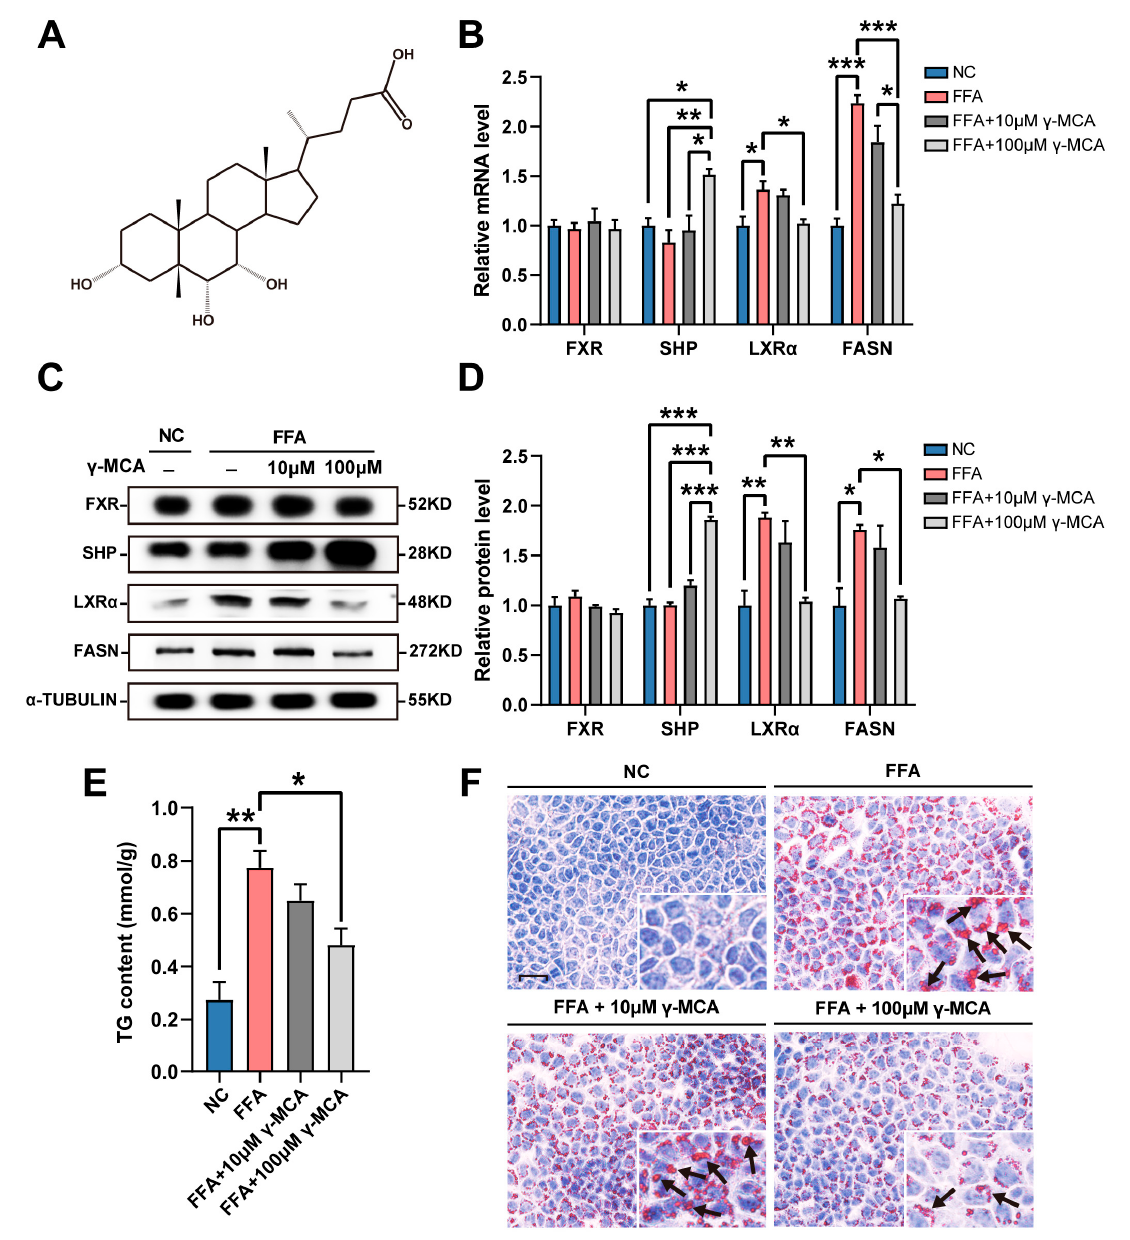
Figure 1. γ -MCA alleviated hepatocellular steatosis by the activation of FXR/SHP/LXR α /FASN signaling. ( A , B ) γ -MCA ( A ) affected AML12 cells, especially at the concentration of 100 µ M, to activate the transcription of SHP and restore the FFA-stimulated abnormalities in LXR α and FASN mRNAs ( B ). ( C , D ) γ -MCA administration increased the SHP expression of AML12 cells, whereas it downregulated their LXR α and FASN levels ( C ) in a dose-dependent manner ( D ). ( E ) FFA stimuli led to TG accumulation, which was attenuated by 100 µ M γ -MCA. ( F ) Oil Red O staining exhibited an augmentation in the number of neutral lipid droplets in the FFA group, and a decrease in the FFA + 100 µ M γ -MCA group (scale bar: 25 µ m). Arrows indicate the lipid droplets in the cytoplasm of hepatocytes. The data were presented as the mean ± SEM. *, p < 0.05; **, p < 0.01; and ***, p < 0.001. free fatty acid, FFA; muricholic acid, MCA; normal control, NC; farnesoid X receptor, FXR; small heterodimer partner, SHP; liver X receptor α , LXR α ; fatty acid synthase, FASN.